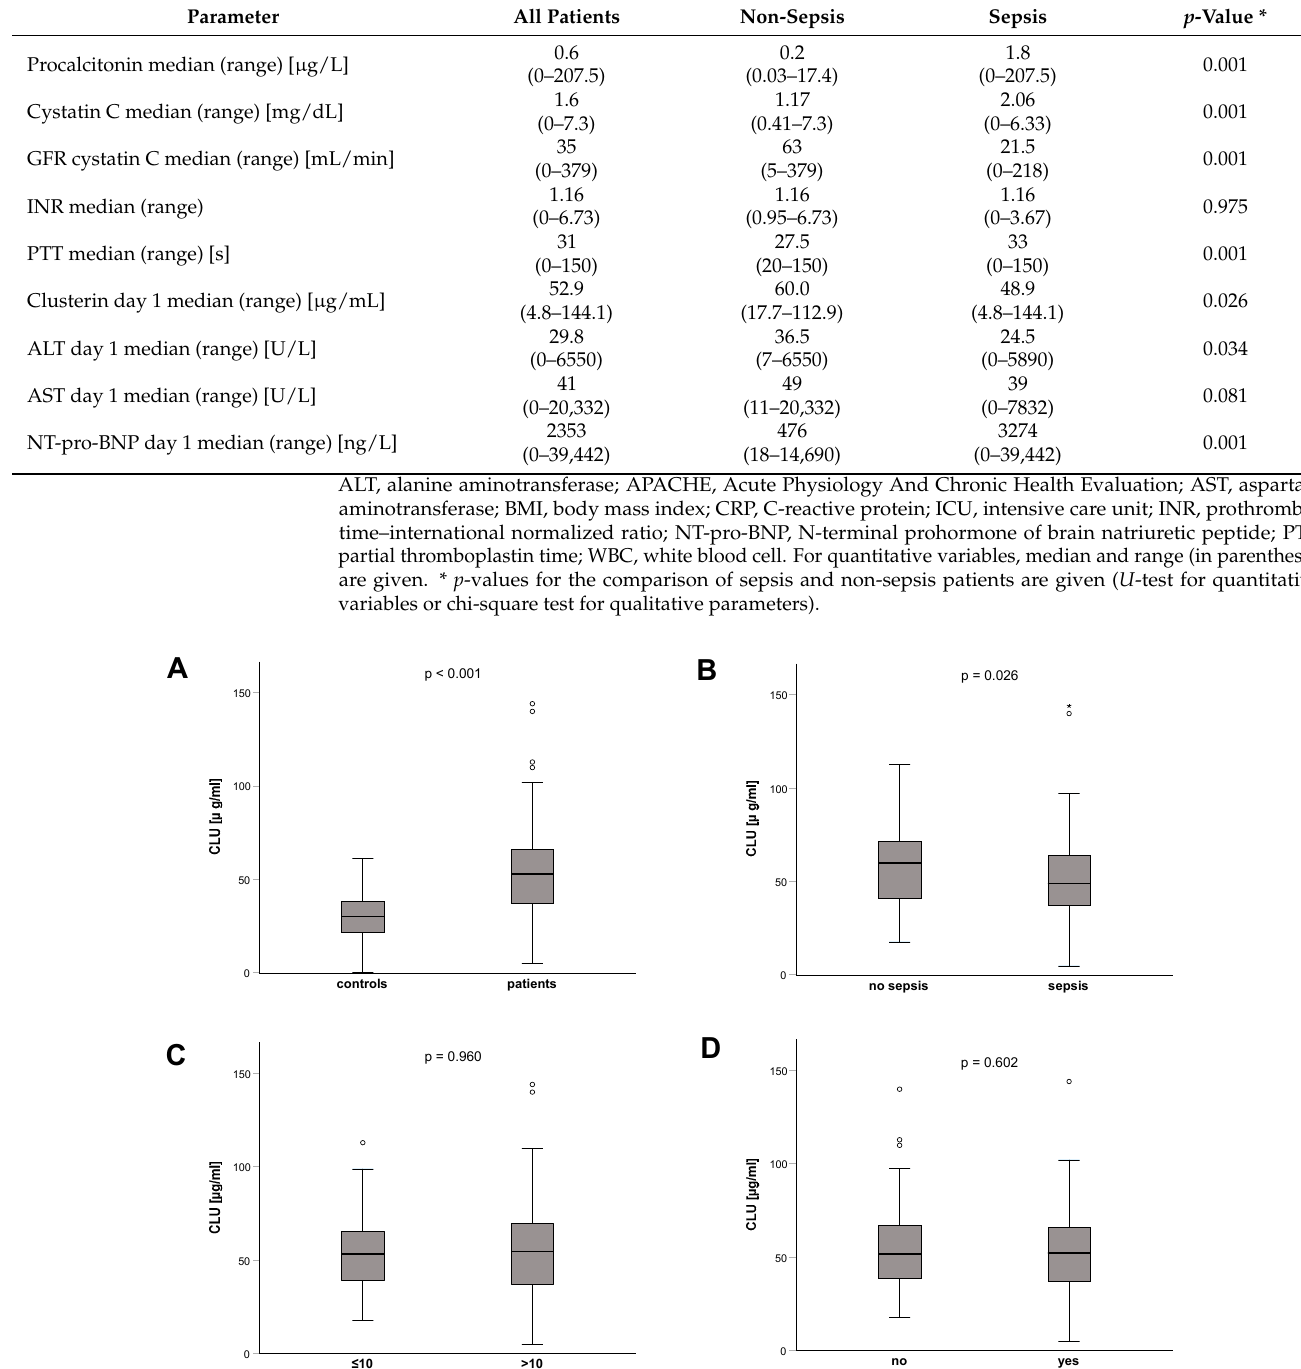
terin plasma concentrations and the various disease etiologies resulting in ICU admission (all p > 0.05; data not shown). Although clusterin has associations to various systemic inflammatory, metabolic, and neurological disorders [28–31], clusterin plasma levels were not associated with es- tablished clinical disease severity scores, such as in critically ill patients with a high Acute Physiology And Chronic Health Evaluation-II (APACHE-II) score above 10 ( p = 0.960) (Figure 1C). Additionally, vasopressor therapy did not significantly alter plasma clusterin concentrations in ICU patients (data not shown). Furthermore, there was also no signifi- cant difference in plasma clusterin levels between ventilated or non-ventilated critically ill patients ( p = 0.602) (Figure 1D). Clusterin concentrations did not differ significantly between male and female pa- tients ( p = 0.727) (Figure 2A), patients aged up to 64 years or older ( p = 0.271) (Figure 2B), or patients with or without certain comorbidities, such as: coronary artery disease ( p = 0.229) (Figure 2C), hypertension ( p = 0.162) (Figure 2D), chronic obstructive pulmonary disease (COPD) ( p = 0.063) (Figure 2E), or liver cirrhosis ( p = 0.690) (Figure 2F). Patients